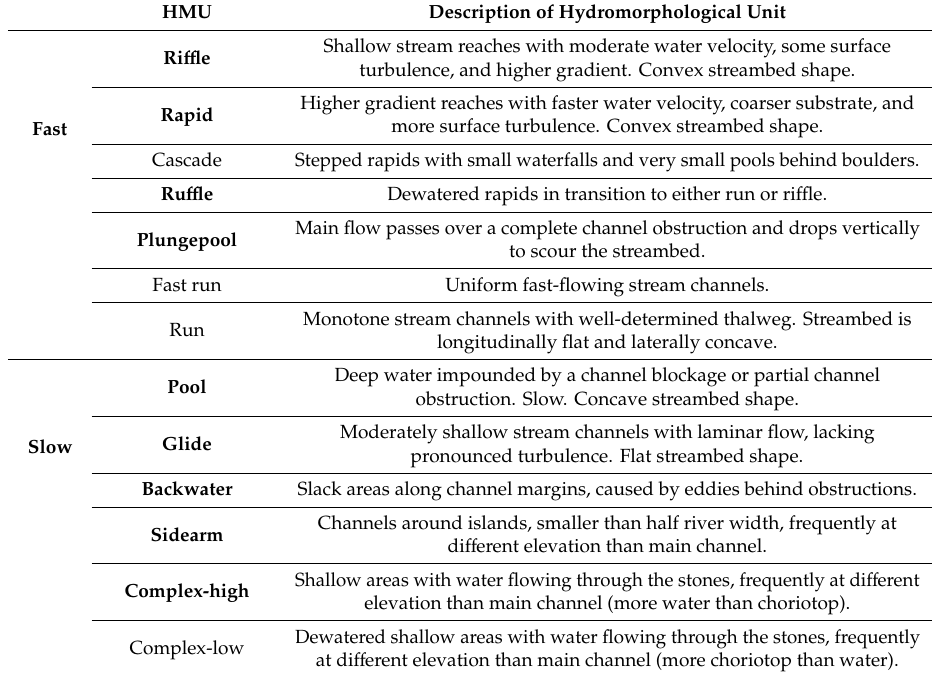
Table 1. Definition of HMUs—hydromorphological units (modified from [13,37,38]). HMUs with fast and slow water velocity are grouped. HMUs marked with bold font were delineated during the survey on the Stura di Demonte River. It is worth noting that some authors [39] treat shallow habitat patches as sub-units, although in this study the standard Mesohabitat Simulation Model (MesoHABSIM) classification was